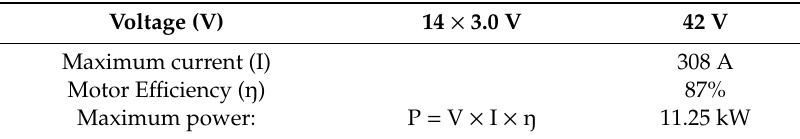
Table 7. Electric engine